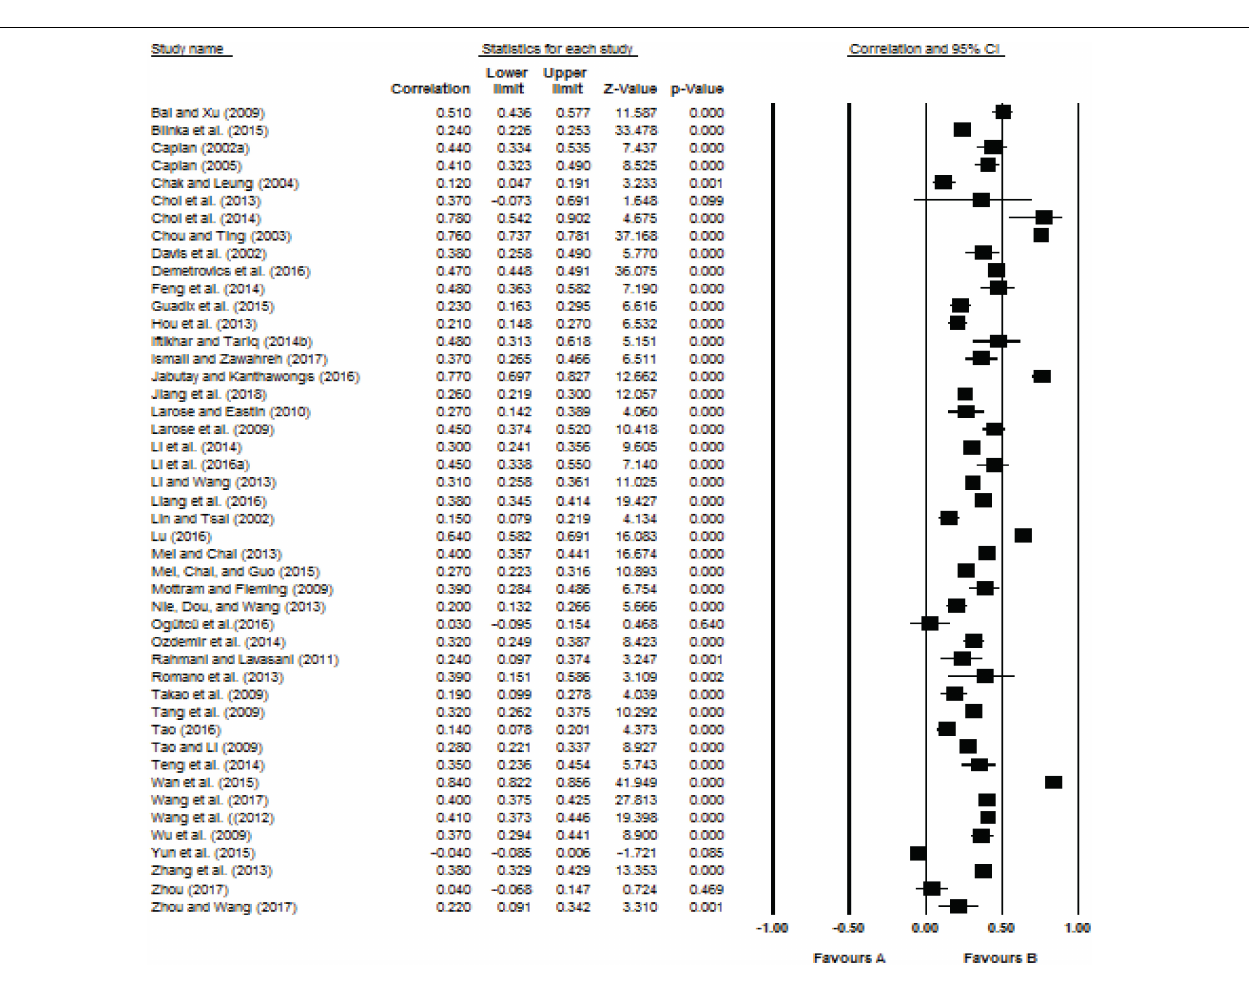
FIGURE 2 | Forest plot for the relationship between impulsivity indicator and Internet